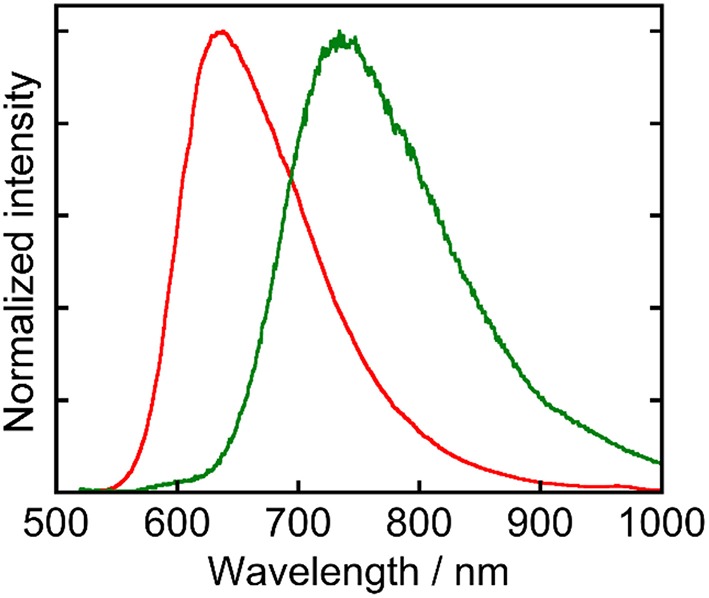
Normalized emission spectra of Ru(pic) (green line) and Ru(dmb) (red line) measured in a DMA solution. The excitation wavelength was 480 nm.